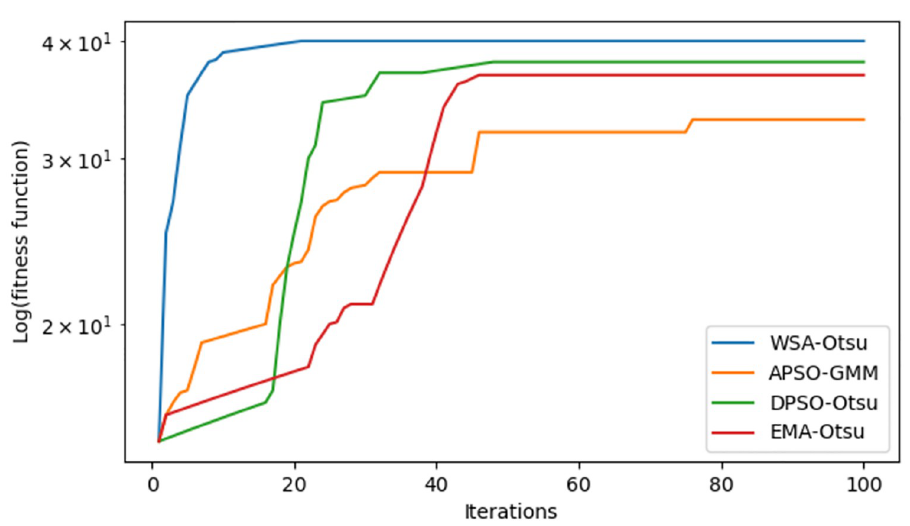
Fig 5. The convergence curves of Otsu method in terms of fitness values at five different levels.